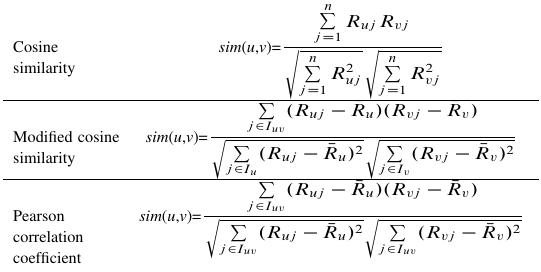
Table 2 Traditional methods for measuring similarities. Cosine